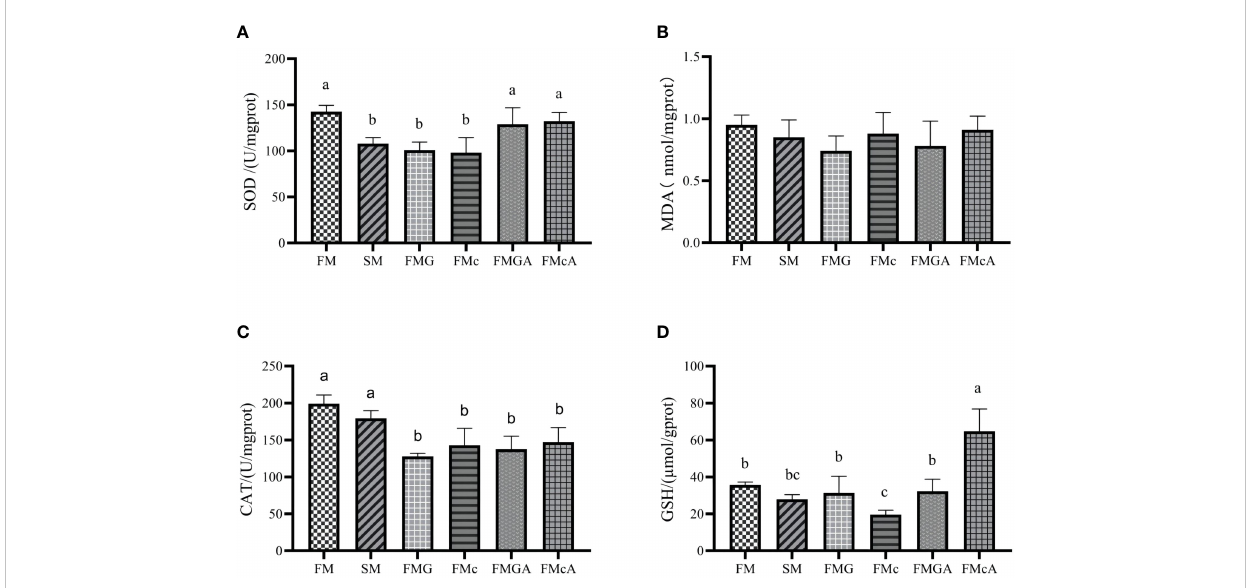
FIGURE 2 Antioxidative ability in the hepatopancreas of mirror carp at different treatment fed with diets containing fi shmeal (FM), soybean meal (SM), glycinin (FMG), B-conglycinin (FMc), AKG+B-conglycinin (FMcA) after eight weeks. (A) T-SOD, total superoxide dismute (U/mg prot); (B) MDA, malondialdehyde (mmol/mg prot). (C) CAT, catalase (U/mg prot); (D) GSH, glutathione (umol/gprot); Data are presented as mean +SE, (n = 6) a, b, c Mean values with different letters were signi fi cantly different (P<0.05).